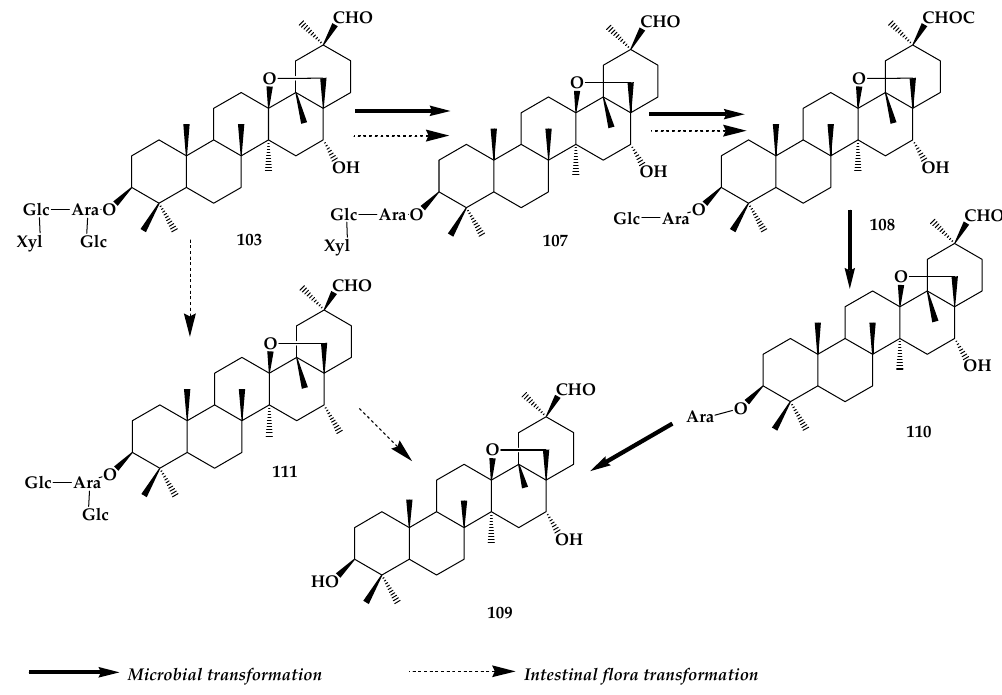
Figure 19. Transformation pathway of ADS- Ⅰ.